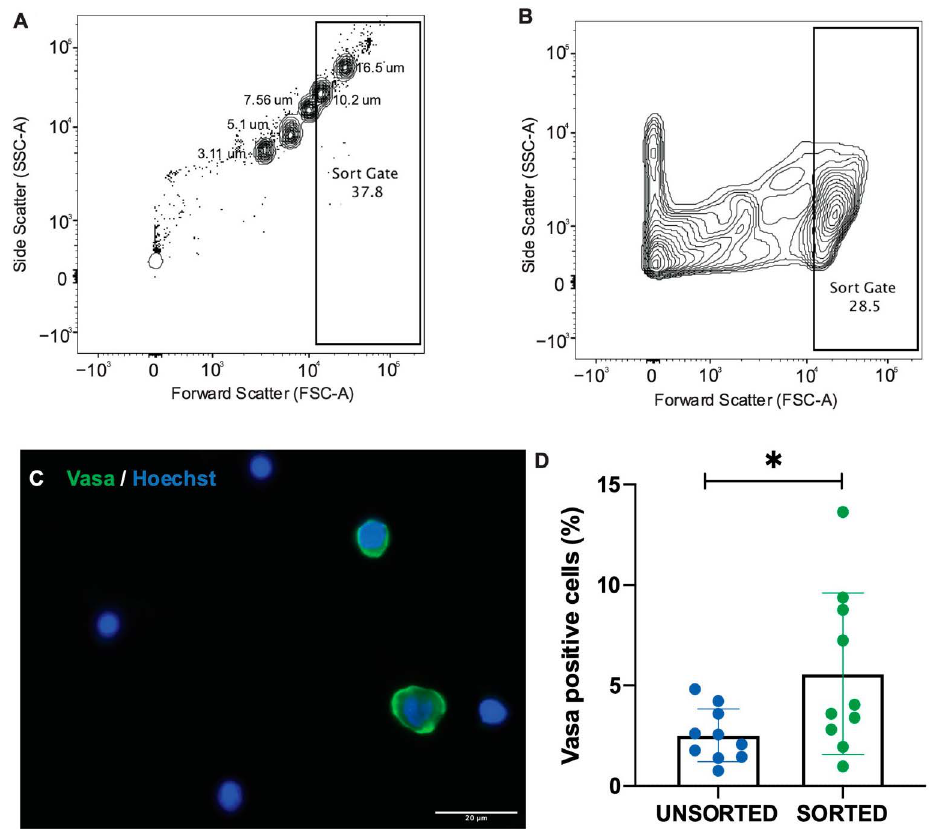
Figure 3. Flow cytometry-based cell sorting method. ( A ) A set of size-specific beads were used to give an approximation of particle size in relation to forward scatter (FSC), a gate was then set to capture events approximately 10 µm and larger. A pooled ( n = 5) ovarian cell suspension was split across 10 samples and each sample was ( B ) sorted by a gate on the flow cytometer. ( C ) An example of Vasa-positive cells in a sorted cell sample. ( D ) The proportion of Vasa-positive cells after sorting was significantly higher compared to unsorted samples (5.85 ± 4.01% vs. 2.53 ± 1.31%, p = 0.0346, level of significance indicated by *; two-tailed t -test, data shown as mean ± standard deviation).